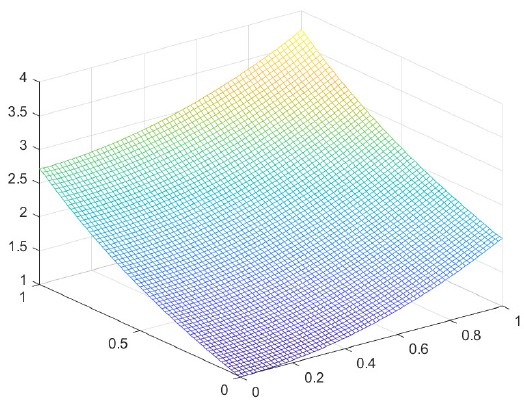
14 of 16 Table 7. Experiment results for the exact solution u = x 2 + e y with B.C. I. N k∇ ( u − u h ) k 1.9001 Table 8. Experiment results for the exact solution u = x 2 + e y with B.C. II. N k∇ ( u − u h ) k 1.8856 Table 9. Experiment results for the exact solution u = x 2 + e y with B.C. V. N k∇ ( u − u h ) k